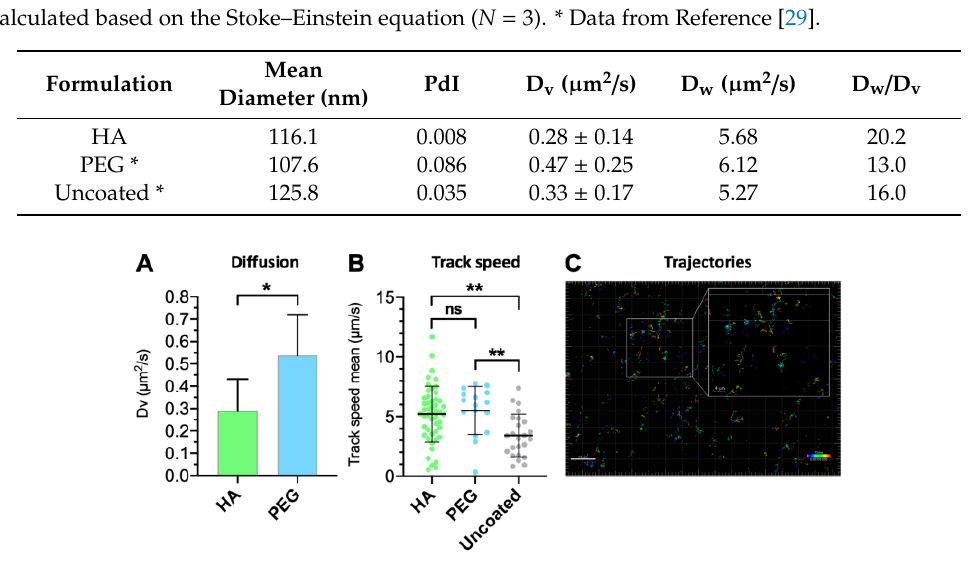
Figure 10. Comparison between ( A ) vitreal diffusion of HA- and PEG-coated light-triggered liposomes, analyzed by unpaired t -test (* p < 0.05); ( B ) ensemble-average speed of HA-coated, PEGylated, and uncoated light-activated liposomes (τ = 1 s). Means with significant differences are shown as analyzed by ordinary one-way ANOVA with Tukey’s multiple comparison test (** p < 0.01). Error bars indicate SD. ( C ) Representative trajectories of the HA-coated liposome in the intact porcine vitreous. Inset shows the zoomed-in view of tracks obtained using the single-particle tracking technique.